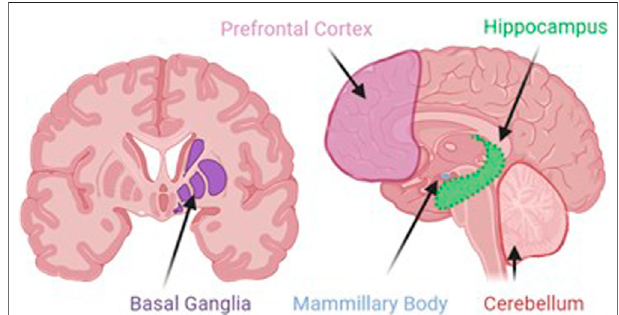
FIGURE 1 | Although alcohol has effects on a number of ubiquitous cellular processes, such as, autophagy, in fl ammation, and stress, the localization of alcohol-induced neurodegeneration is likely to be speci fi c to areas where alcohol produces its greatest effects. These areas include the prefrontal cortex, the site of working memory and executive function processes;basalganglia,thedopaminergicsiteofmotorinitiationandhabitual behavior; the mammillary bodies, the hypothalamic nuclei that integrate with the emotion and memory centers of the limbic system; the hippocampus,